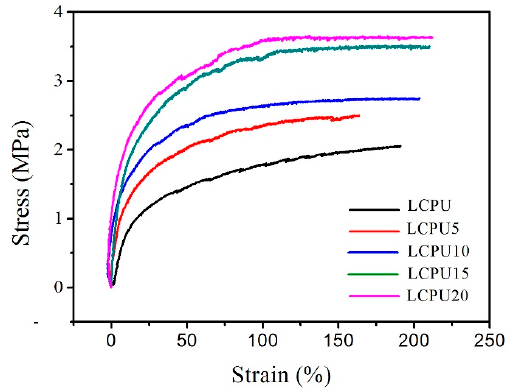
Figure 8. Stress–strain curves of the pristine LCPU and its composites at room temperature. Stretching rate was set at 50 mm/min.